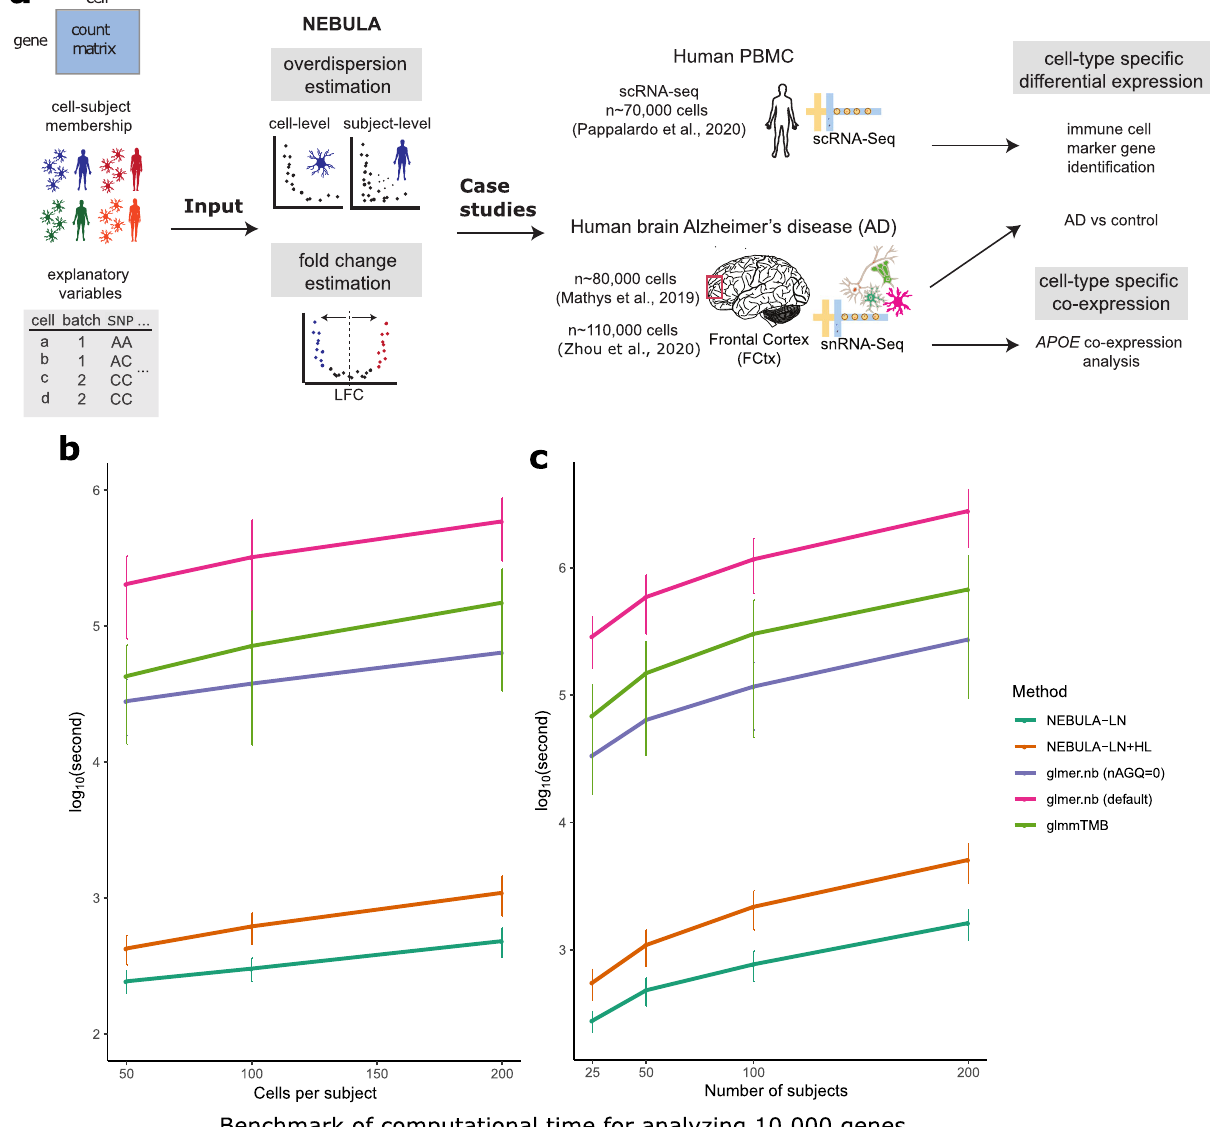
Fig. 1 Overview of the input, output, and computational ef fi ciency of NEBULA. a A fl owchart of NEBULA including the input data, the major estimation steps in NEBULA, and the analyses that were conducted using NEBULA in the application to the real data 5,27,78 . b The computational time (measured in log 10 (seconds)) of fi tting an NBMM for 10,000 genes with respect to CPS by NEBULA, glmer.nb 18 , and glmmTMB 19 . The number of subjects was set at 50. c The computational time (measured in log 10 (seconds)) of fi tting an NBMM for 10,000 genes with respect to the number of subjects. The error bars represent one standard deviation of n = 10,000 genes. The CPS value was set at 200. Two fi xed-effects predictors were included in the NBMM. The average benchmarks were summarized from scenarios of varying subject-level and cell-level overdispersions and the CPC value of a gene ranging from exp ( − 4) to 1. CPS: cells per subject. CPC: counts per